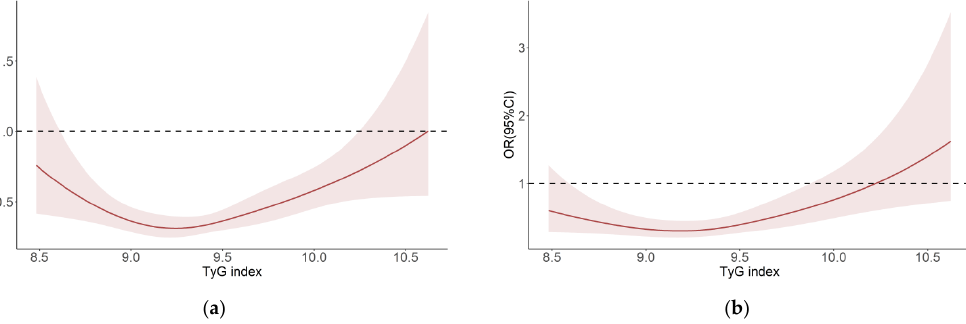
Figure 2. The association between the baseline TyG level and DR based on restricted cubic splines. The odd ratios for DR (solid line) and 95% confidence intervals (shaded portion) are presented. ( a ) Correlation between DR and TyG index in the crude model. ( b ) Correlation between DR and TyG index adjusts for age, gender, race, education, PIR, HDL, LDL, TC, hypertension history and retinopathy history.